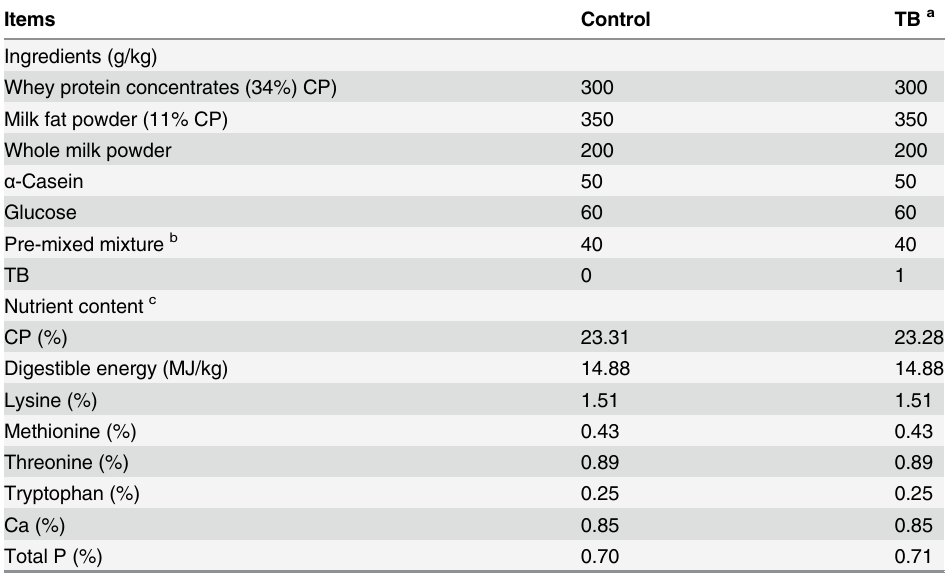
CP (%) Digestible energy (MJ/kg) Lysine (%) Methionine (%) Threonine (%) Tryptophan (%) Ca (%) Total P